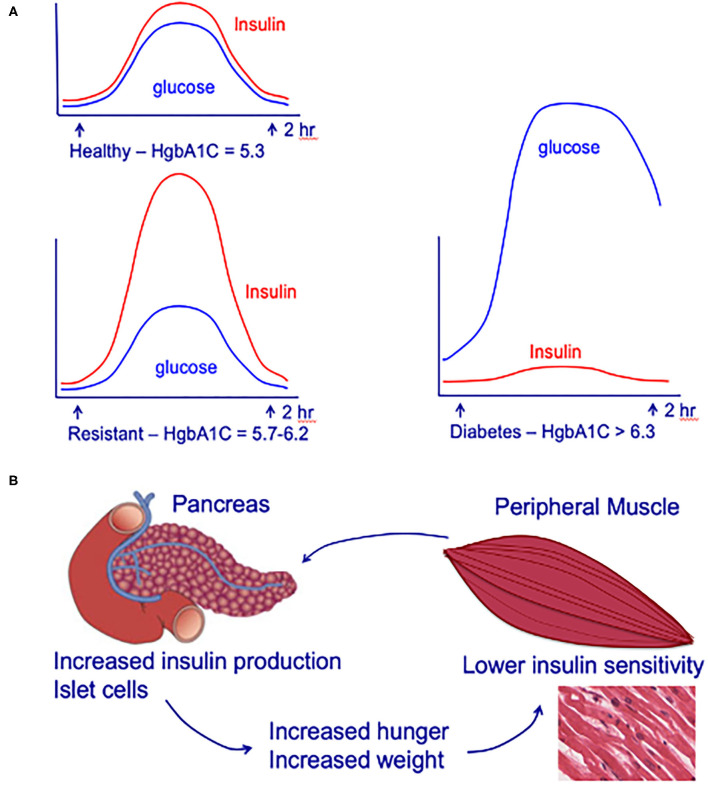
(A) Circulating insulin and glucose levels in healthy individuals (Healthy), insulin-resistant individuals (Resistant), and individuals with type-2 diabetes (Diabetes) at baseline and at 2 h after eating. (B) Impact of insulin-resistance on pancreatic islet cells, peripheral muscle, and individual. Insulin resistance in peripheral muscle tissue results in increased insulin demands from the pancreas. Increased circulating insulin drives hunger and increases weight, leading to a positive feedback loop that increases the chance of an individual developing type-2 diabetes. Adapted from (42).